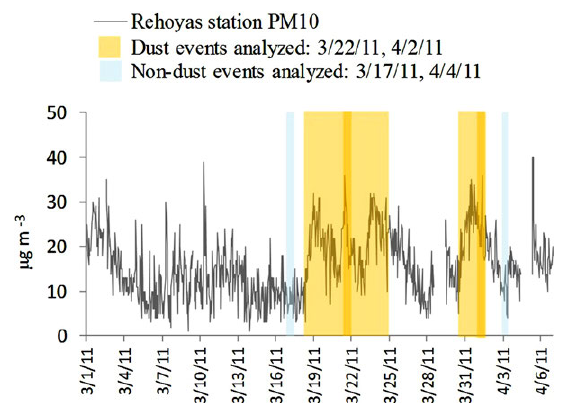
Fig. 2. – Airborne concentration in particles <10 mm (PM10) meas- ured at Las Rehoyas station, Gran Canaria Island. Selected periods during both dust and non-dust events are highlighted. Las Rehoyas is an urban station placed at 86 m.a.s.l in the northeast of Las Pal- mas de Gran Canaria (source: Formulario de Datos Históricos de la Red de Control y Vigilancia de la Calidad del Aire, Gobierno de Canarias ; http://www.gobiernodecanarias.org/medioambiente/ calidaddelaire/datosHistoricosForm.do).